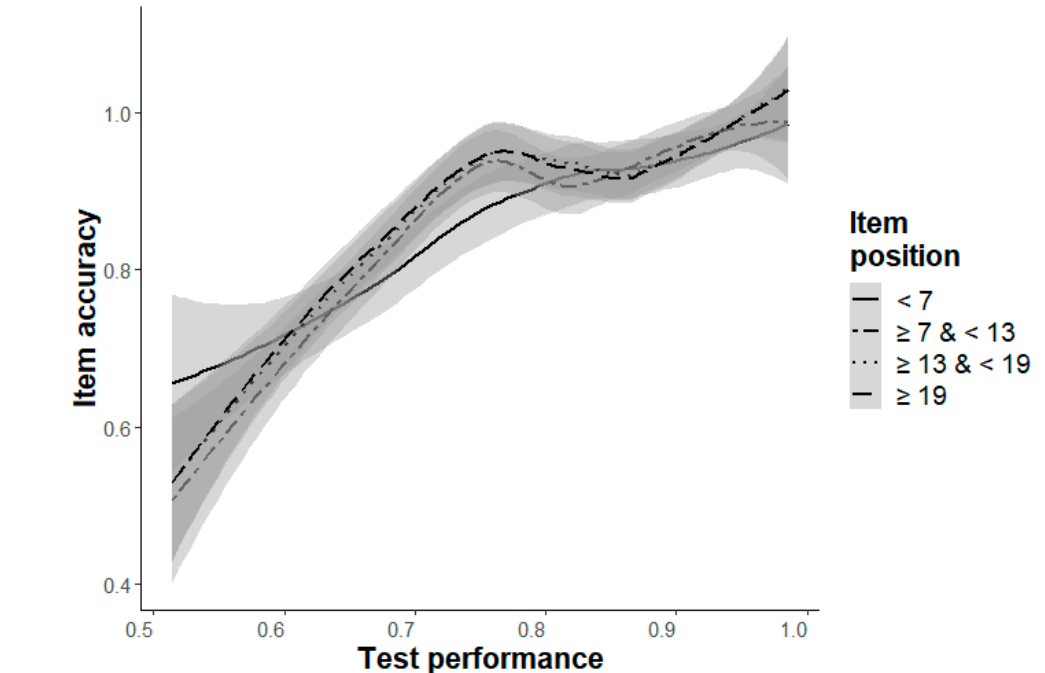
Figure 2. Changes of item accuracy depending on test performance (ACC-poss, x-axis) and item position (grouped into four intervals, indicated by four lines) with a .95-confidence-interval for Level a.